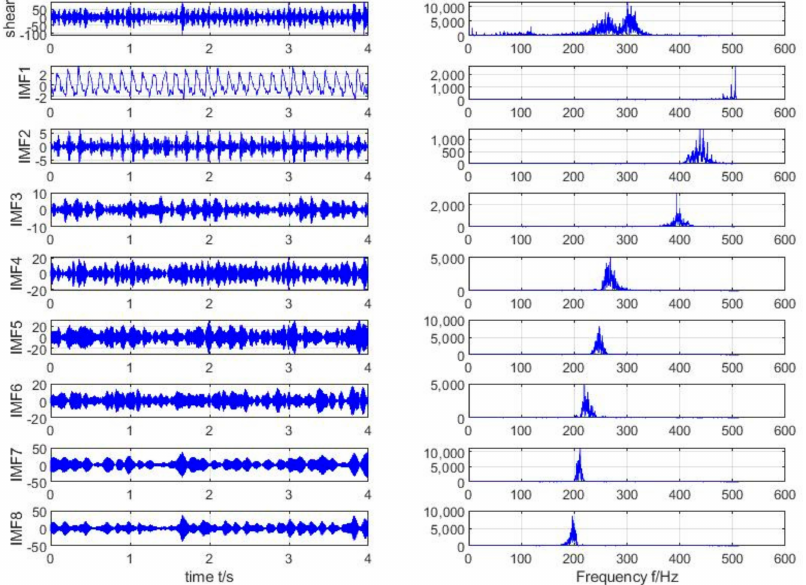
Figure 4. VMD decomposition results of shear signals in time-frequency